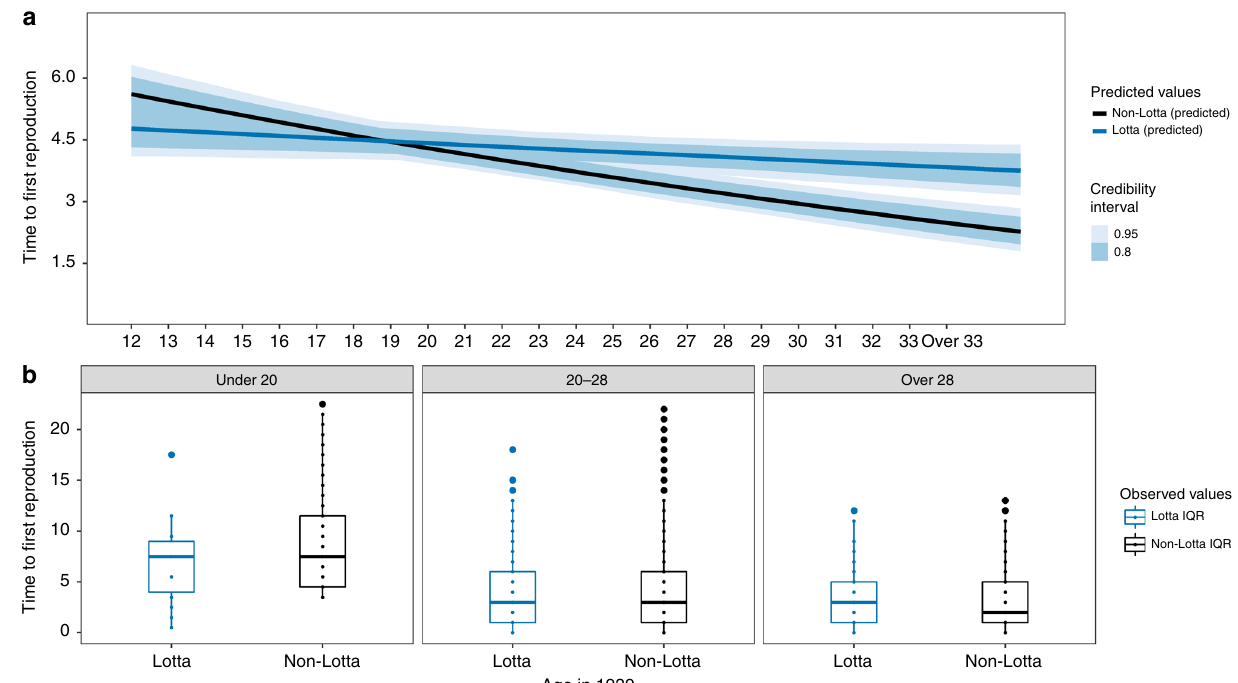
Fig. 3 In the sisters only analysis (see Methods: Statistical Analysis) the effect of volunteering on time to reproduction after the war was also age speci fi c such that younger volunteers waited less (and older volunteers more) time to give birth than their sisters who did not volunteer. a Model- generated posterior distribution predictions (dark lines), credibility intervals (shaded). b The observed data (median — solid line, box — interquartile range (25% and 75%), whiskers — 5% and 95% intervals) for years to reproduction ( y -axis) for age groups “ Under 20 ” , “ 20 – 28 ” , and “ Over 28 ” when the war began in 1939. See Supplementary Materials: Fig. 2a and Table 2 (top panel, right side) for posterior distributions for all covariates and Supplementary Fig. 4a for Posterior predictive check for this model. Differences between the model-generated predictions in panel a and the observed data (panel b ) primarily result from the impact of covariates entered into the